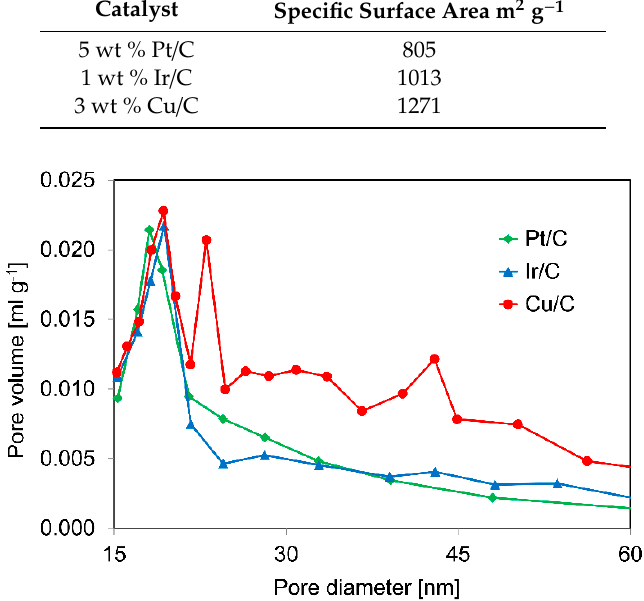
Figure 2. Pore size distributions of the different C-supported catalysts.